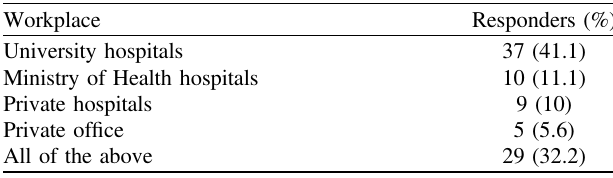
Table 1. Distribution of spine surgeons according to workplace.